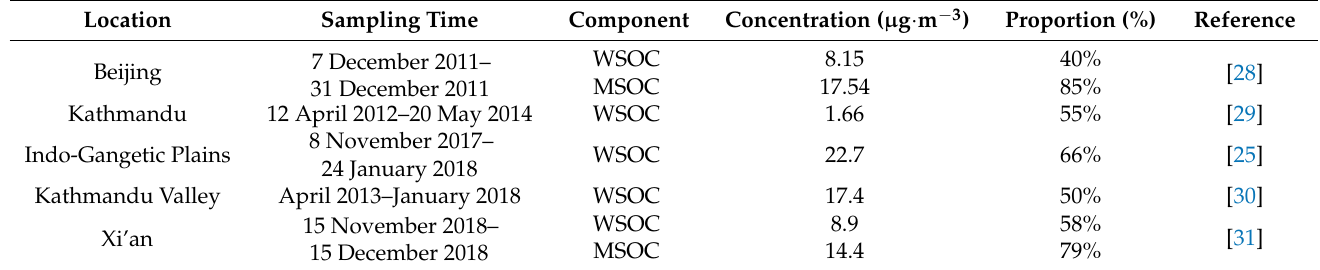
Table 2. The concentrations and proportions of WSOC and MSOC in other studies.